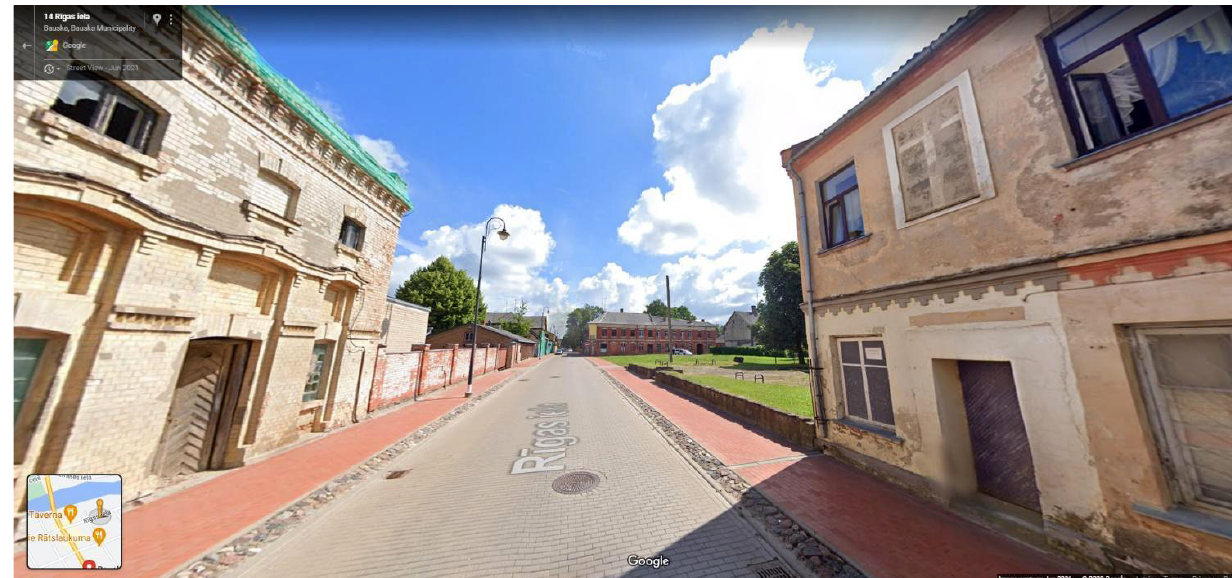
Figure 4. Rīgas Street in Bauska, 30 m from the central square. Abandoned buildings and spaces can be seen in the front; a bit further to the right, there is a vacant plot and an abandoned square, and in the back, the buildings to the left are partially abandoned and covered with a green safety net to guard against accidents. The quality of pavement materials can be observed, as well as the disturbed level of existing entrances and the reconstructed pedestrian